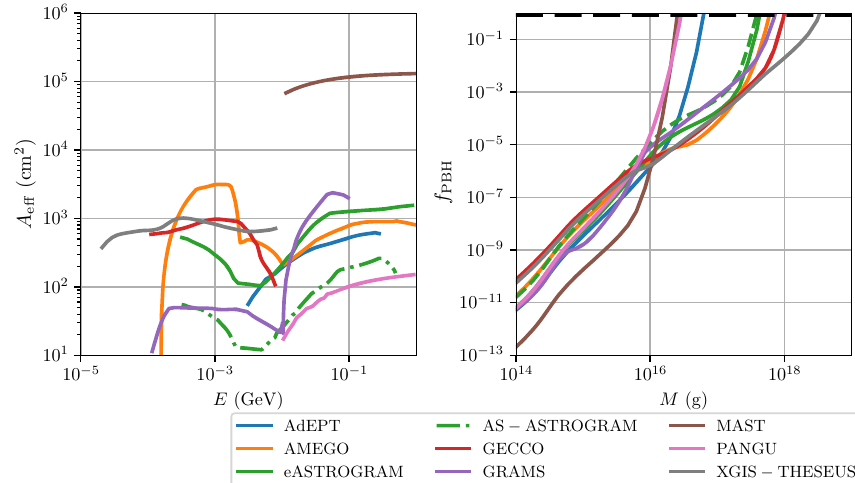
PBH mass range probed here. Right: PBH constraints from GC+EXGB observations using the method M 2 with the background of 2